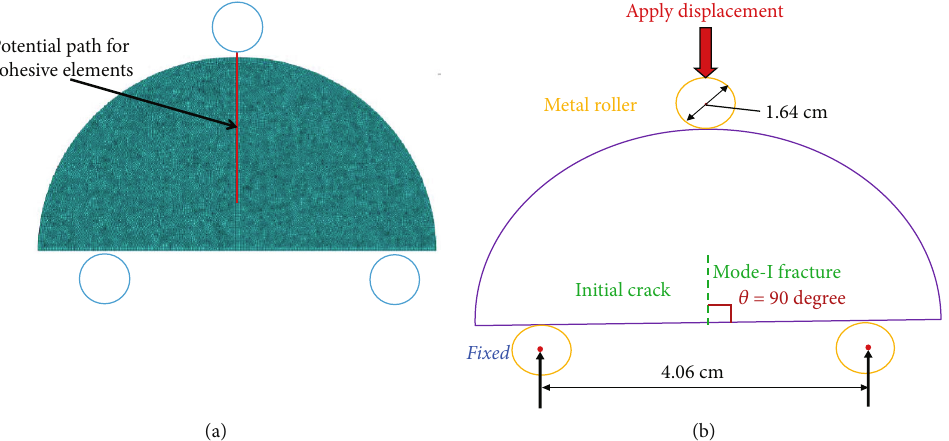
Potential path for cohesive elements